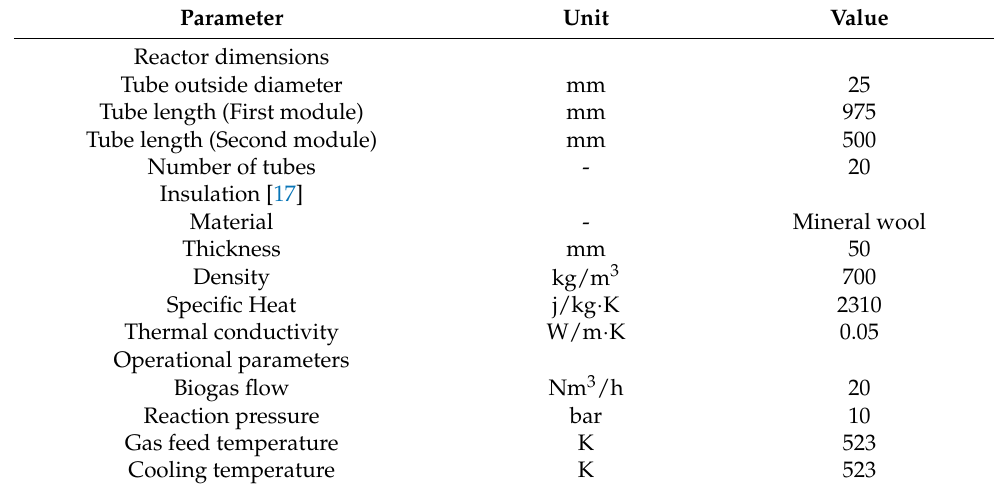
Figure 2. Physical domain and boundary conditions of the CFD model. ( a ) Full domain. ( b ) Tubes and baffle domains (porous media and solid). ( c ) Longitudinal cut view at plane YZ. (1) Coolant (fluid domain). (2) Tubes (porous media domain). (3) Baffles (solid domain). (4) Velocity inlet at coolant domain. (5) Mass flow inlet at porous media domain. (6) Tubes pressure outlet. (7) Coolant domain pressure outlet. (8) Thermal coupled walls at tubes to coolant and baffle to coolant interfaces. (9) Convective heat transfer coefficient at external walls. Table 1. Operational conditions and reactor technical